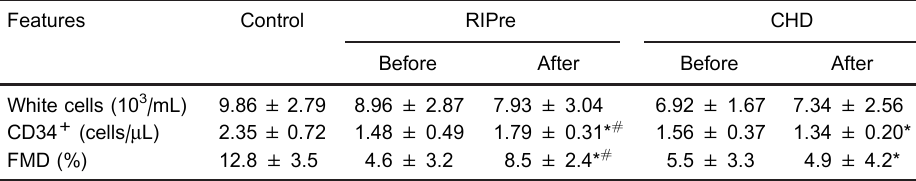
Table 3. Number of endothelial progenitor cells (CD34 + ), white cells and flow-mediated dilation (FMD) in remote ischemic preconditioning (RIPre) and coronary heart disease (CHD) patients and the control